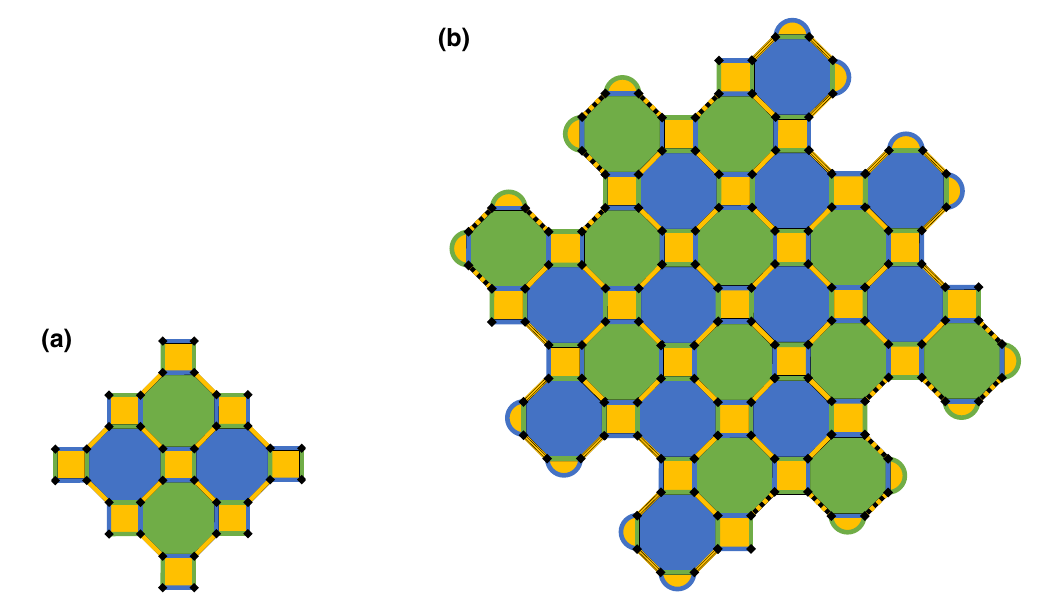
FIG. 2. (a) The tiling unit for the 4.8.8 Floquet code. As in Fig. 1(a), qubits are indicated by black dots. Every diagonal edge is YY , every horizontal edge ZZ , and every vertical edge XX . (b) The rectangular boundary conditions for the 4.8.8 Floquet code. As in the honeycomb code, the solid-color edges are measured in a period-6 sequence (yellow, blue, green, yellow, green, blue). The dashed and striped black-yellow edges are the same Pauli type as the solid yellow edges but are measured at different rounds in the measurement sequence. The dashed edges, incident to green faces, are measured during the first yellow round. The striped edges, incident to blue faces, are measured during the second yellow